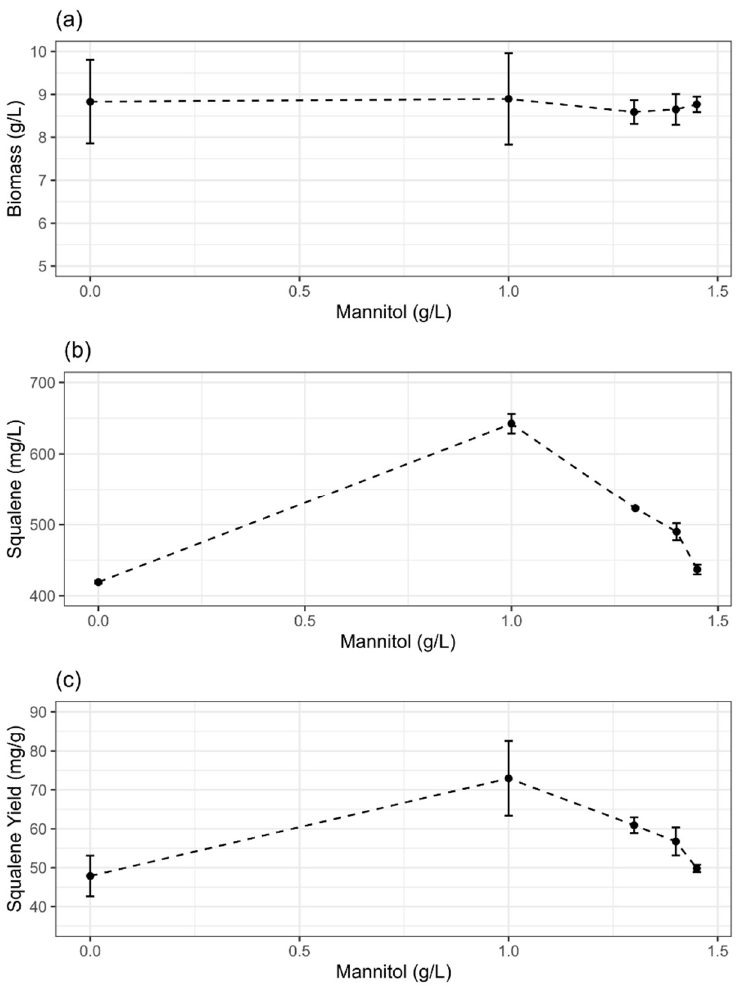
Figure 1. Effects of mannitol supplementation on the ( a ) biomass, ( b ) squalene concentration, and ( c ) squalene yield of ATCC 26185 strain. The data are provided for 72 h grown culture and expressed as mean ± SD of triplicate experiments.